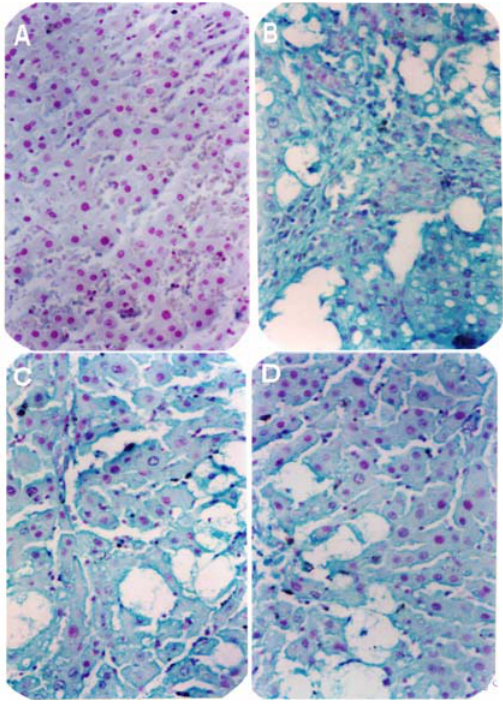
FIGURE 4. Section of liver stained with Feulgen stain showing DNA in hepatocytes (A) control (normal) rat; (B) CCl 4 - treated rat showing decreased DNA contents; (C) CCl 4 + DDB (375 mg/kg)-treated rat showing mild improvement in DNA content; (D) CCl 4 + DDB (75 mg/kg) + silymarin (22 mg/kg)-treated rat showing moderate improvement in DNA contents (Feulgen reaction x